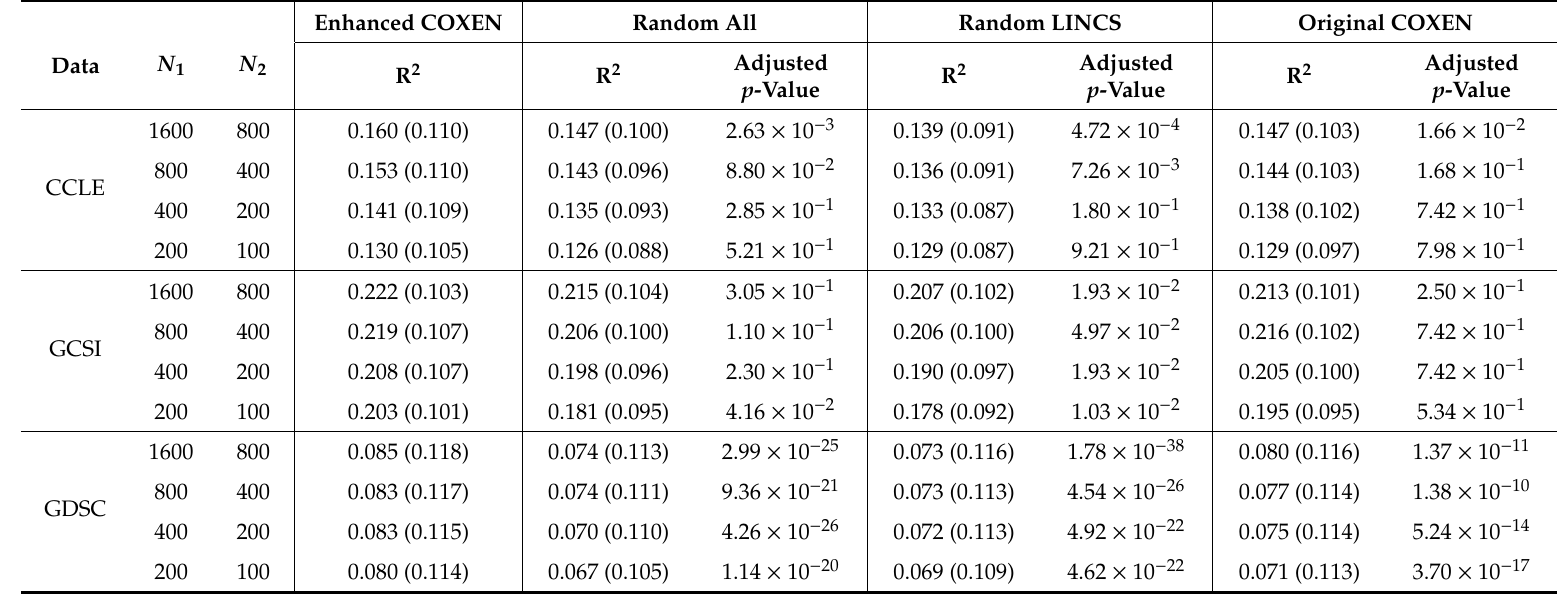
Enhanced COXEN, Original COXEN, Random All, and Random LINCS refer to the enhanced COXEN method, the original COXEN method, genes randomly picked from all available genes, and genes randomly picked from the LINCS set, respectively. In the R 2 columns, the number before the parenthesis is the average R 2 across drugs and the number in the parenthesis is the standard